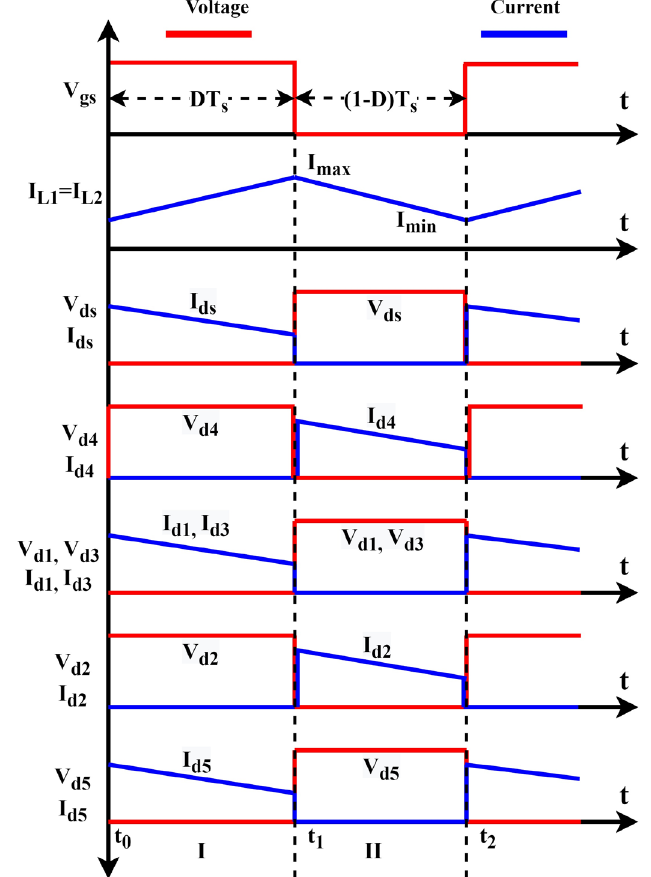
Figure 3. Theoretical waveforms of the MQZS step-up converter.